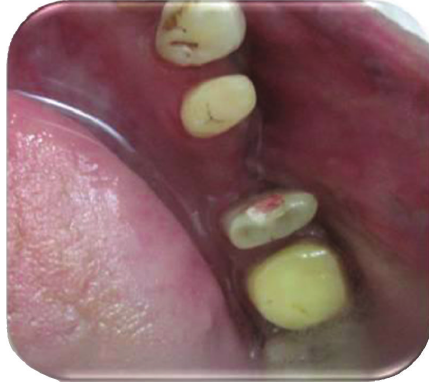
Figure 5: Tooth preparation done.